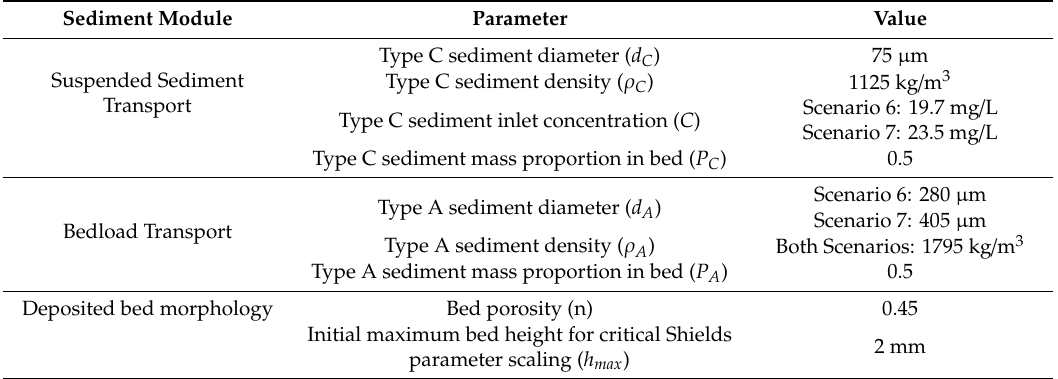
Table 2. Sediment parameters used in SSF for the A Coruña sediment deposition validation Scenarios 6 and